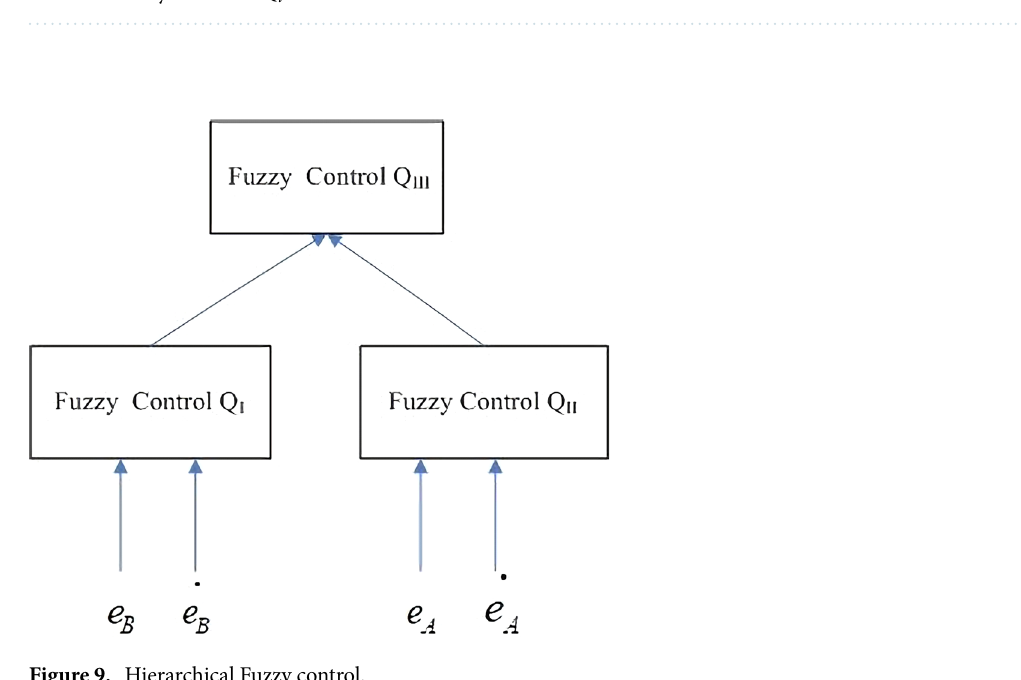
Table 3. Fuzzy rule for (cid:31) Q i